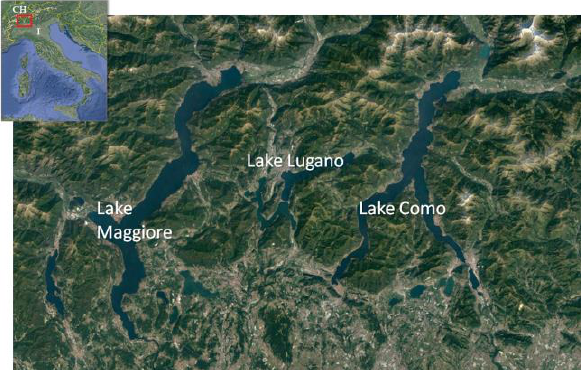
Figure 1. The Insubric lakes Lugano, Maggiore and Como (North-Western Italy/Southern